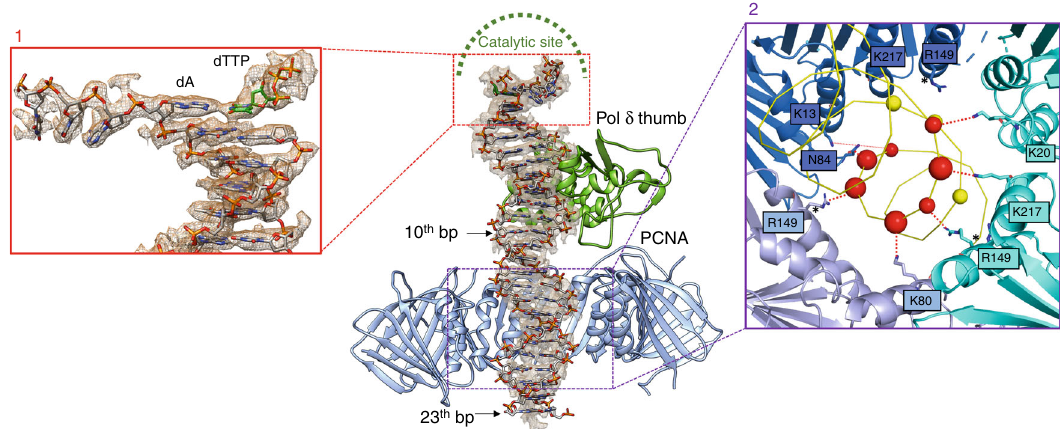
Fig. 3 Interaction of the processive Pol δ holoenzyme with DNA. Map region around dsDNA and model, showing that DNA is held in place by the polymerase thumb domain, and stabilized by the PCNA central channel. The N-terminal, palm and fi ngers domains of Pol δ and the PCNA monomer in the foreground are removed for clarity. Inset 1: Cryo-EM map region and model of primer/template DNA in the Pol δ active site. The terminal adenine in the primer strand and paired incoming dTTP are labeled. Inset 2: PCNA interactions with DNA. PCNA subunits are shown as cartoons and colored in different shades of blue. DNA is shown as a yellow ribbon. DNA phosphates within a coulombic interaction distance (<6 Å) from PCNA residues are shown as spheres. Interacting phosphates on the template and primer strands are shown in red and yellow, respectively. Phosphates closer than 5 Å are shown with a larger sphere diameter. PCNA interacting residues are shown as sticks and labeled. The asterisk indicates that the side chain of R149 is fl exible, but could approach a phosphate group at a distance <6